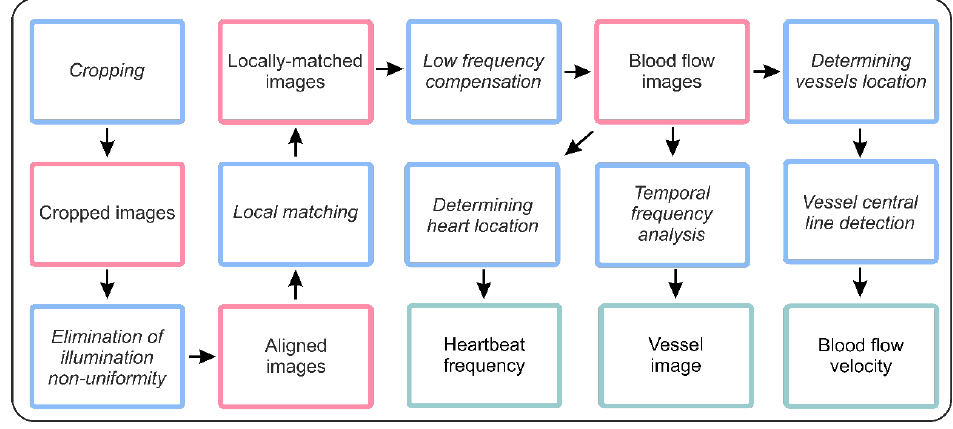
Figure 2. Image processing pipeline.